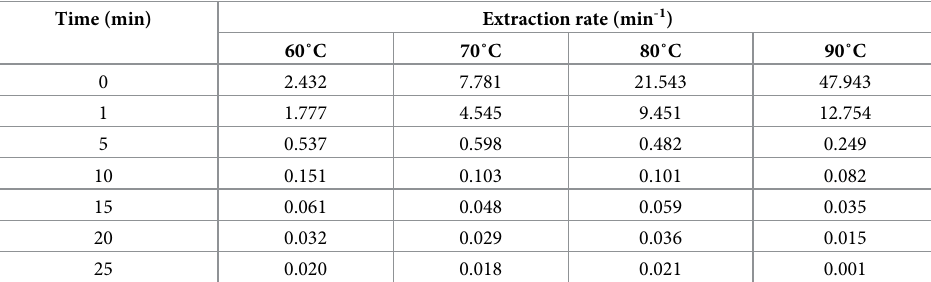
Table 4. The variation of extraction rate of EPA against reaction time using